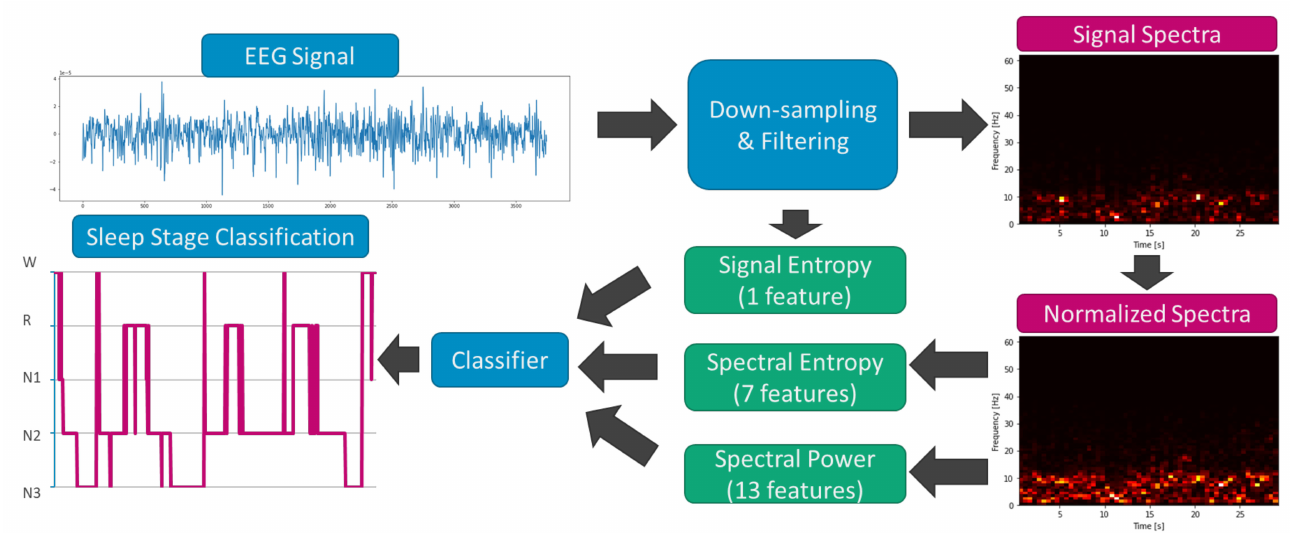
Figure 2. Feature extraction and classification flowchart. For each 30 s EEG input, a signal entropy and a spectrogram were derived. The spectrogram was normalized to enhance the spectral pattern. A normalized spectrogram was then used to extract the power band values and the spectra entropy. Finally, all of the features were fed to a Gaussian SVM classifier for